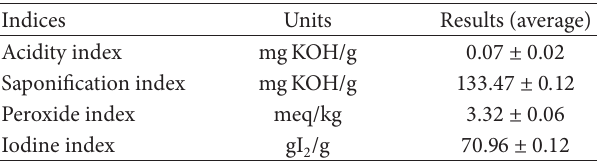
Table 3: Fatty acid composition from the wash waters (total mixture) of the biodiesel obtained from viscera of